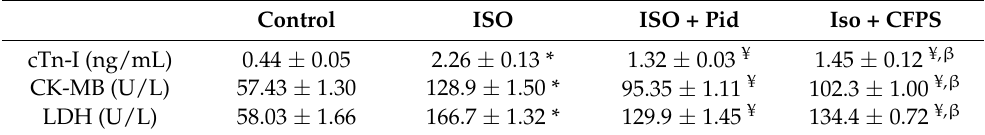
Table 4. Effect of CFPS fraction on cardiac biomarkers.